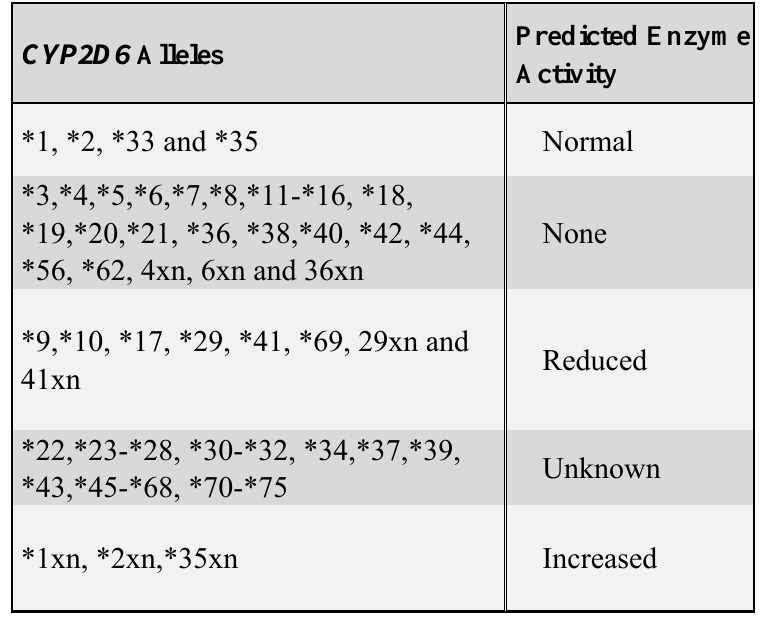
Table 1. CYP2D6 alleles and their effect on enzyme